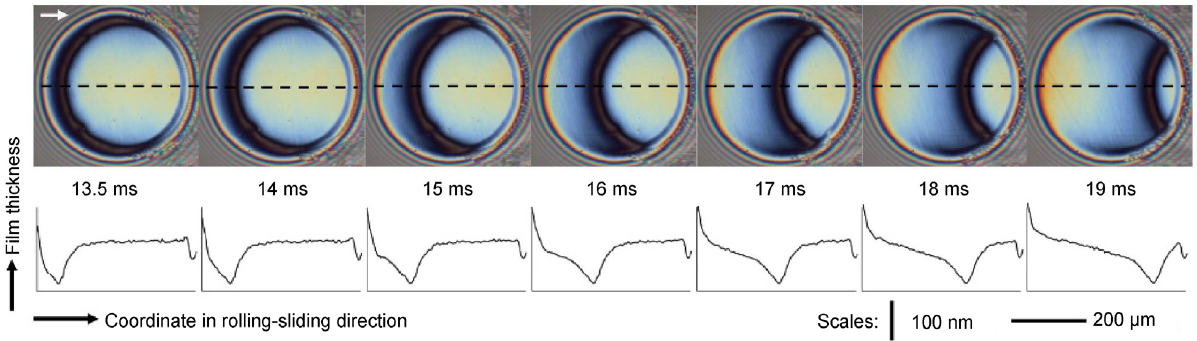
Fig. 7 Evolution of film thickness during propagation of